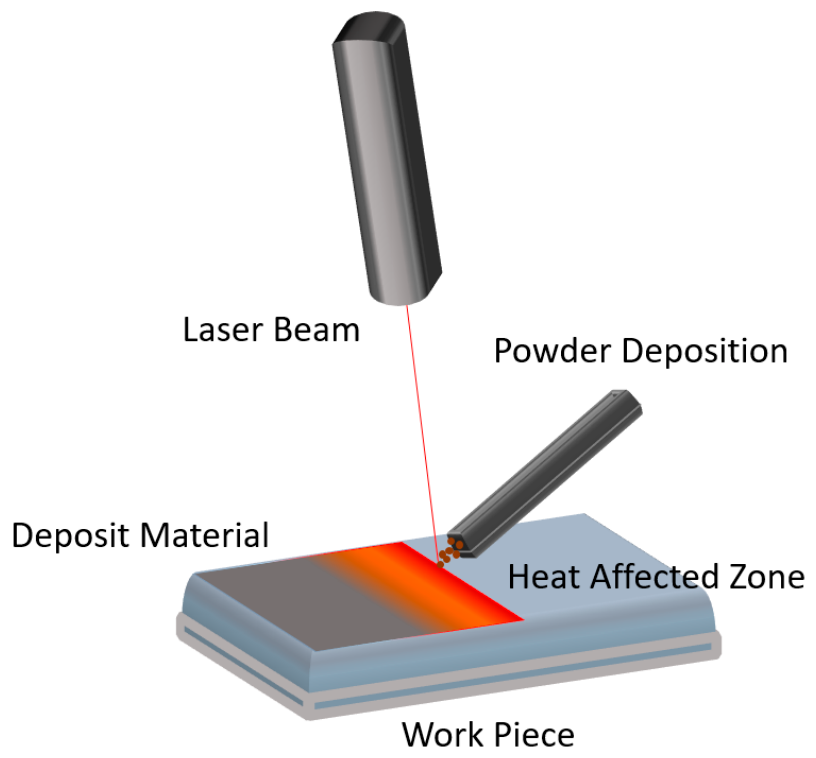
Figure 7. A general schematic of a powder feed system.